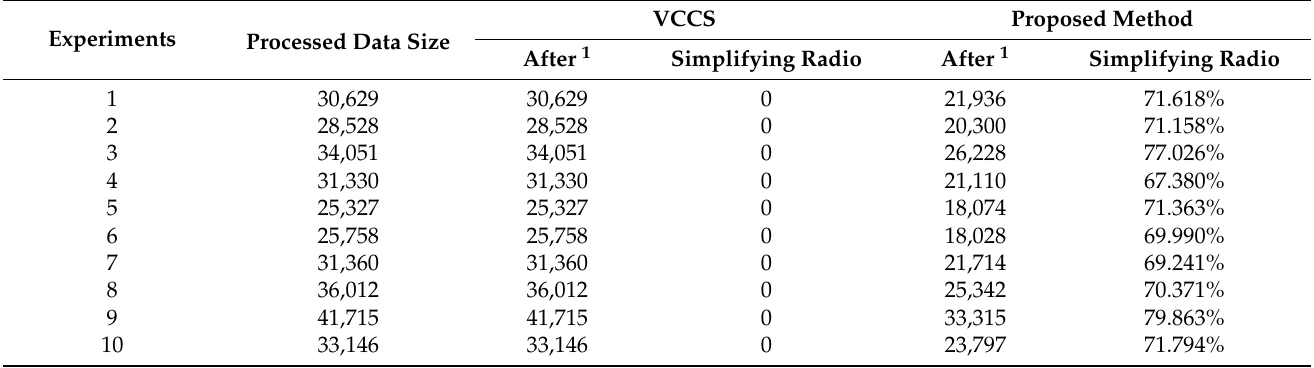
Table 1. The simplifying example results of our method ( R voxel = 1 mm , R seed = 20 mm